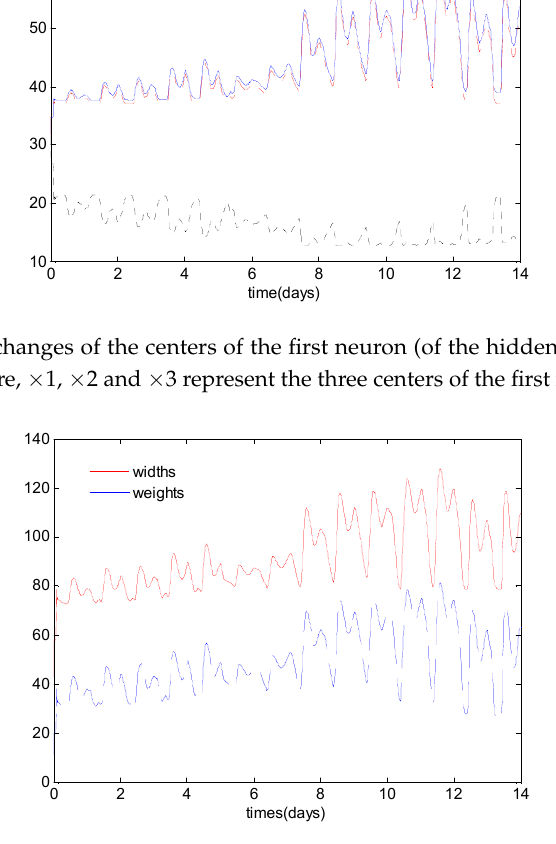
Figure A4. Dynamic changes of the weights and widths of the first neuron (of the hidden layer neurons) of the neural network.